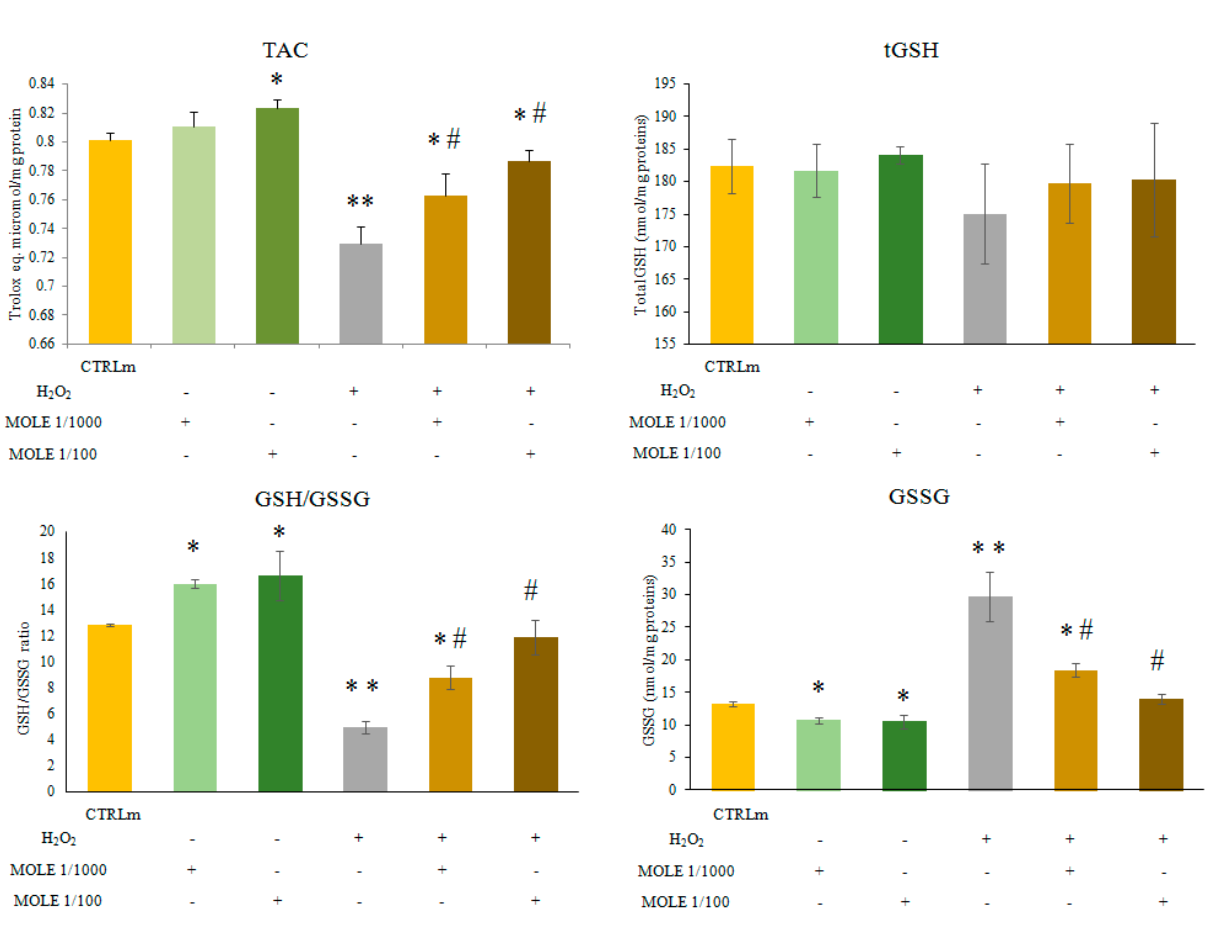
Figure 3. Total antioxidant capacity (TAC) and glutathione homeostasis analysis. Measurement of total antioxidant capacity (TAC), total glutathione (tGSH), oxidized glutathione (GSSG), and reduced to oxidized glutathione ratio (GSH/GSSG) was performed in C2C12 myotubes treated with MOLE stock solution dilutions (1/1000 and 1/100 working solution) or vehicle (methanol) in culture media for 24 h and in samples treated for a further hour with hydrogen peroxide (1 mM) with pre-treatment with vehicle or MOLE. Data presented are the mean ± S.D. of three experiments. * p < 0.05; ** p < 0.01 vs. CTRLm; # p < 0.05 vs. H 2 O 2 .